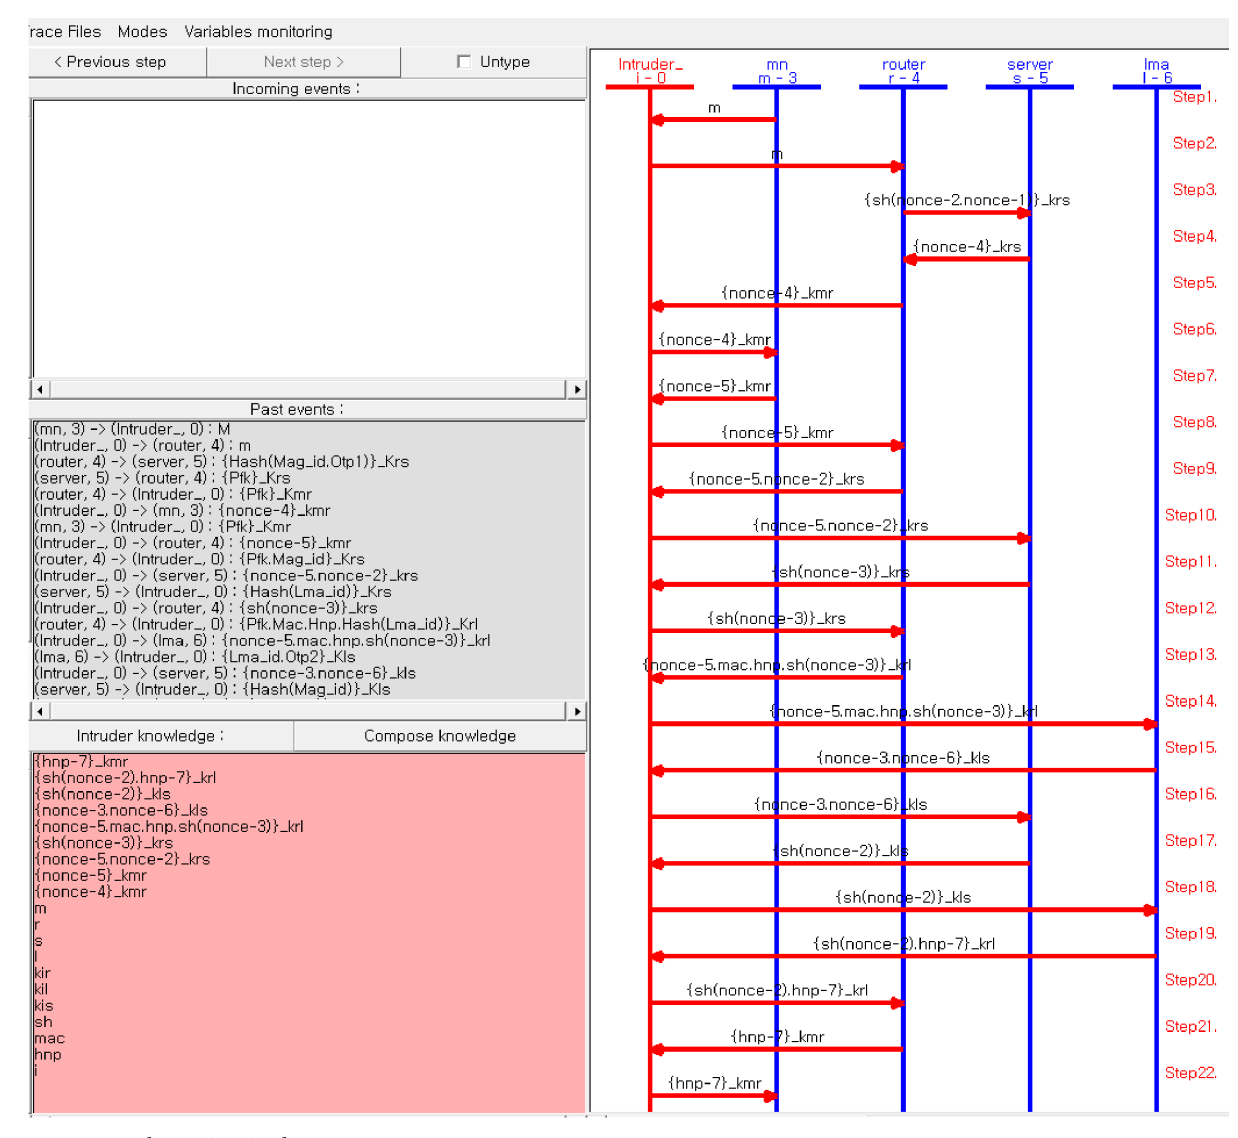
Fig 5. Protocol execution